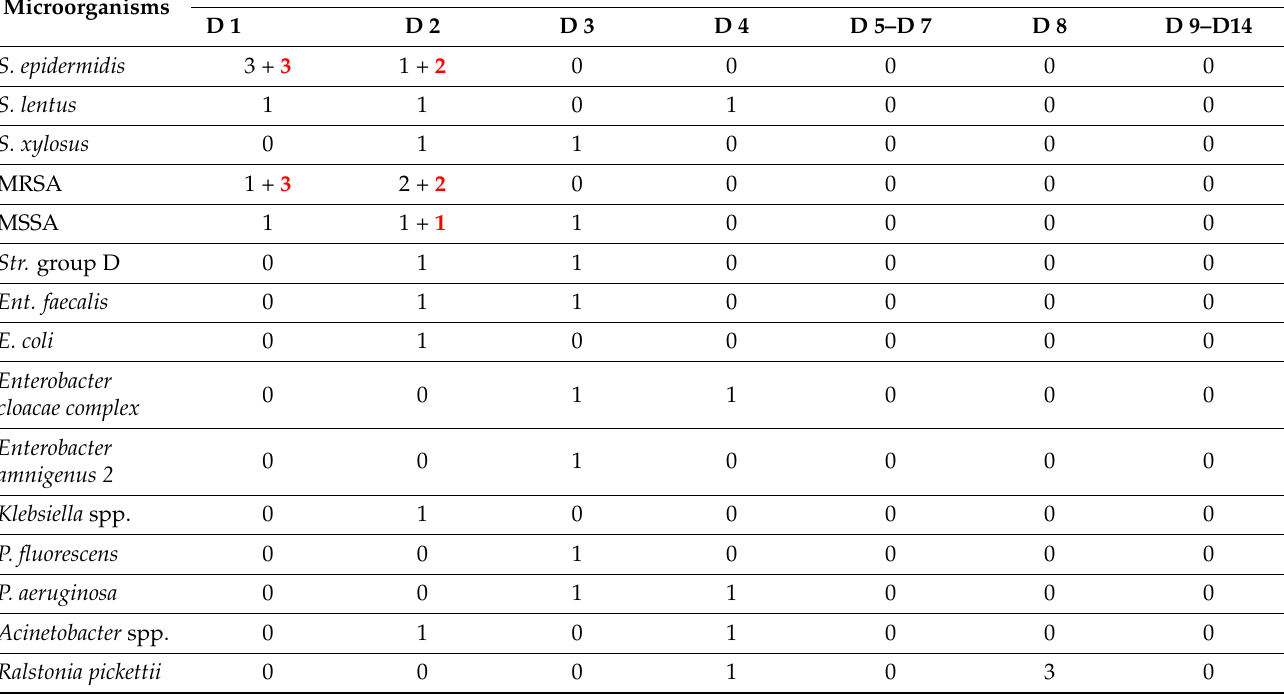
Table 1. Isolated bacterial species (no. of strains identified) from sonication fluid/incubation period days.